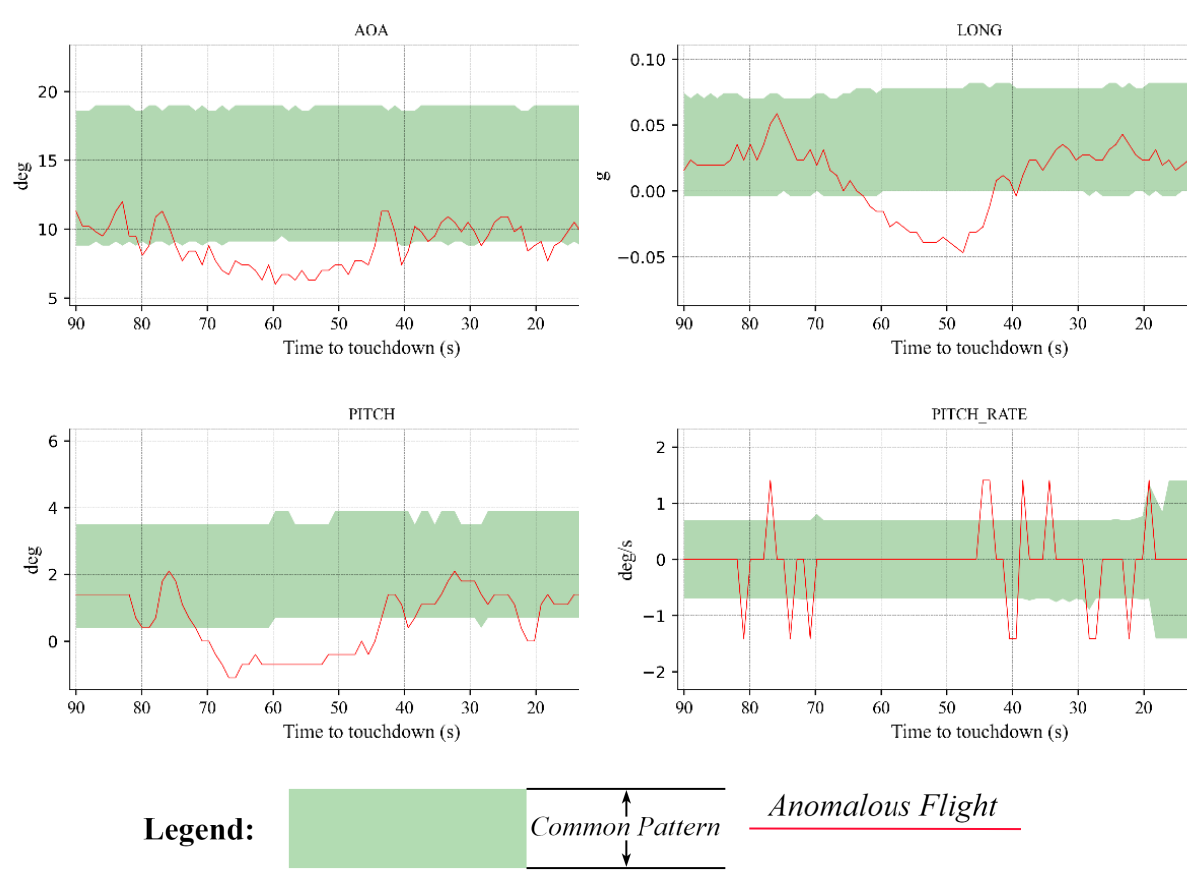
Figure 14. An example of an anomalous flight that landed at the ZUUU airport.